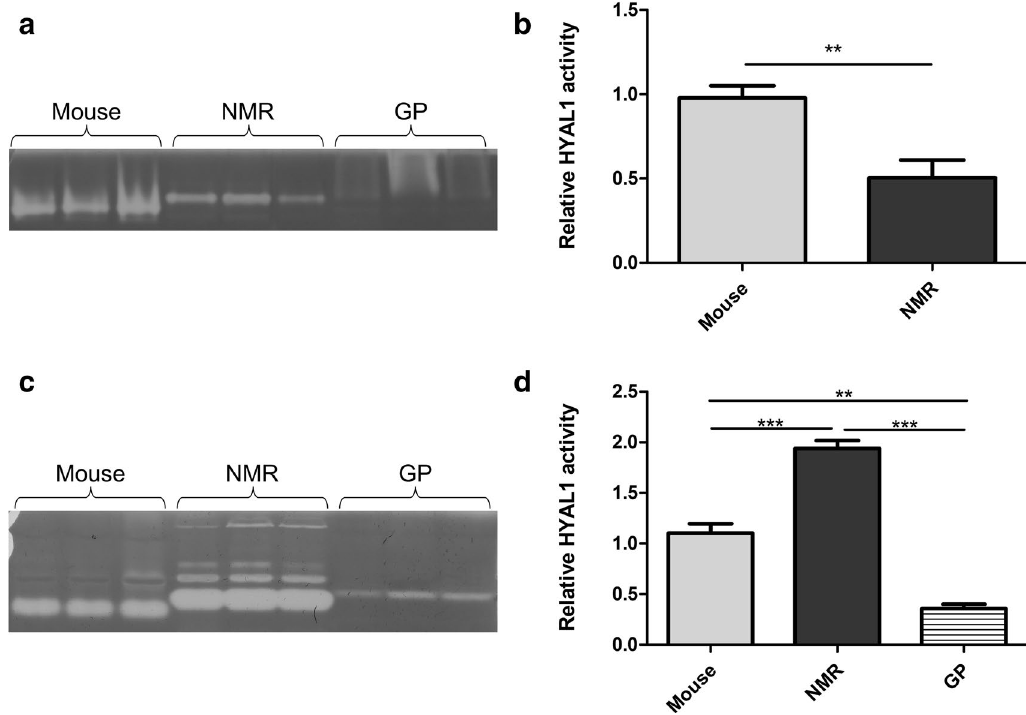
Figure 10. HYAL1 activity in NMR, GP, and mouse lymph nodes ( a , b ) and serum ( c , d ). HYAL1 activity was measured using native zymography in mouse, NMR, and GP ( a ) lymph nodes, and ( c ) serum (cropped gels). Relative HYAL1 activity was assessed in ( b ) lymph nodes (n = 3), and ( d ) serum (n = 3). Means ± SEM are shown. Differences are significant (***P < 0.001; **P < 0.01; *P < 0.05) in mouse vs NMR lymph nodes (Student’s t-test; no detectable activity was found in GP lymph nodes), and between the three species in serum (ANOVA and Bonferroni test). Full-length blots/gels are presented in Supplementary Fig.